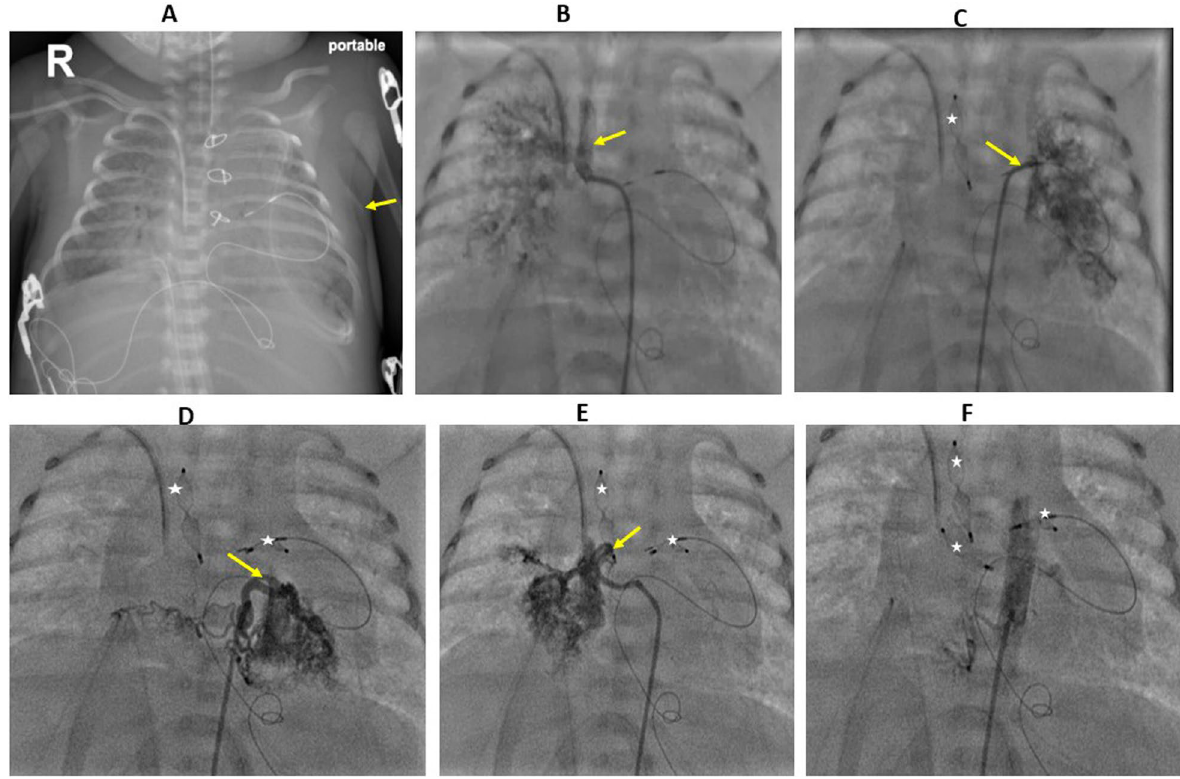
Fig. 1 Roentgenogram and angiography before and after the closure of MAPCAs: A chest X‑ray after ASO showed pulmonary edema with significant skin edema (yellow arrow). B selective angiography showing a large MAPCA supplying the right upper lung lobe (yellow arrow). C selective angiography showing a large MAPCA supplying the left upper lung lobe (yellow arrow) with vascular plug seen closing the MAPCAs of right upper lobe (white asterisk). D selective angiography showing MAPCA supplying the left lower lung zone with vascular plugs seen occluding MAPCAS for upper left and right lungs (white asterisks). E selective angiography showing large MAPCA supplying the right lower lung lobe (yellow arrow). F Successful closure of 3 MAPCAs using three vascular plugs (white asterisks). ASO: arterial switch operation, MAPCAs: Major aortopulmonary collateral